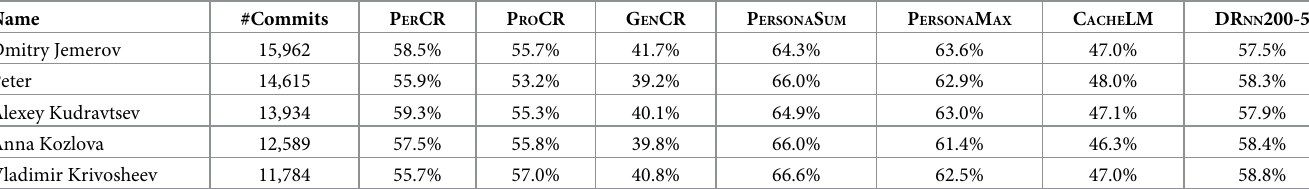
Table 3. Recommendation accuracy of top-contributed programmers in intellij-comm .